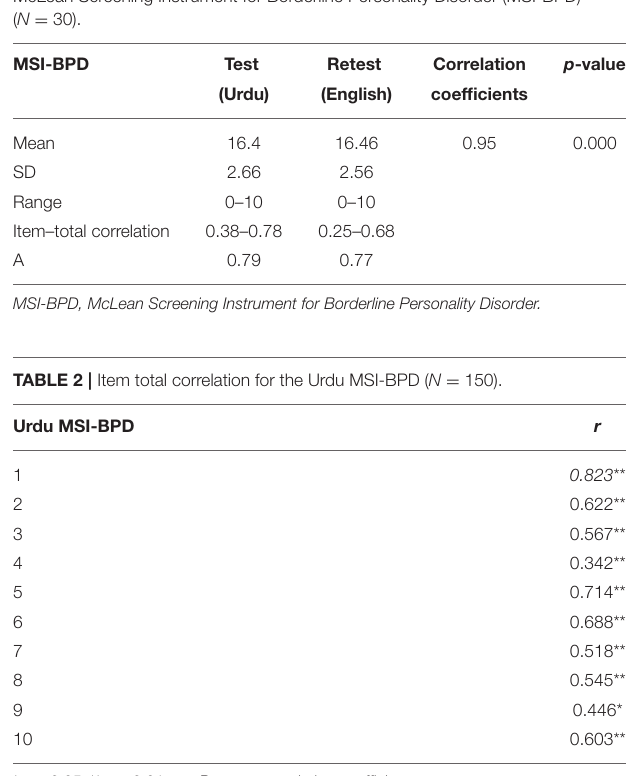
TABLE 1 | Mean and standard deviation, Pearson product-moment correlation coefficient, test–retest reliability of both the Urdu and English versions of the